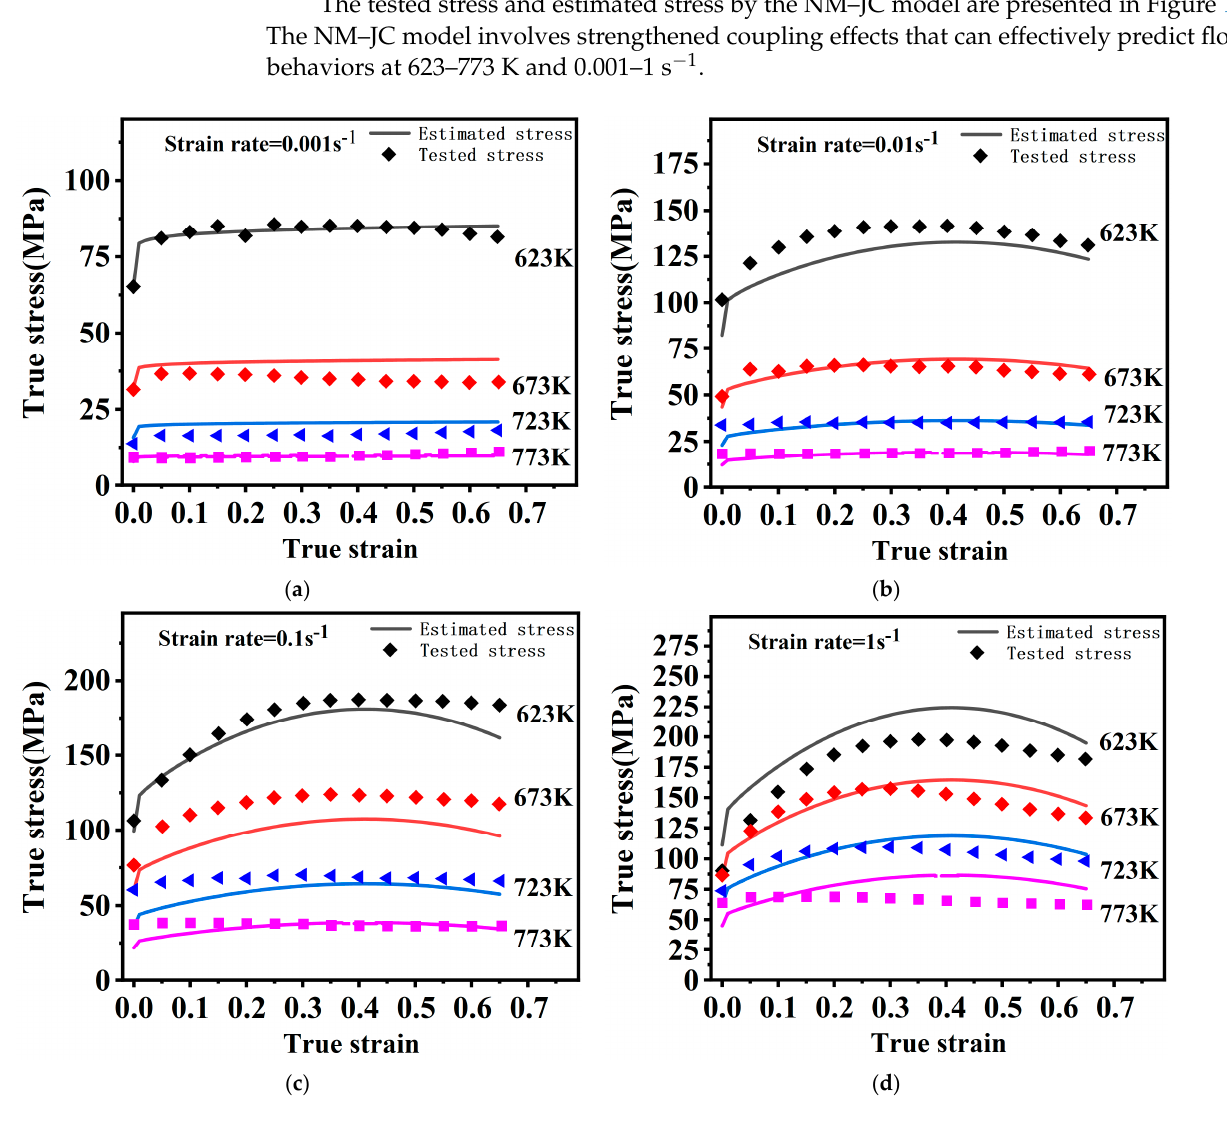
Figure 11. Tested stress and estimated stress by the NM–JC under different conditions. ( a ) 0.001 s − 1 , ( b ) 0.01 s − 1 , ( c ) 0.1 s − 1 , ( d ) 1 s − 1 .